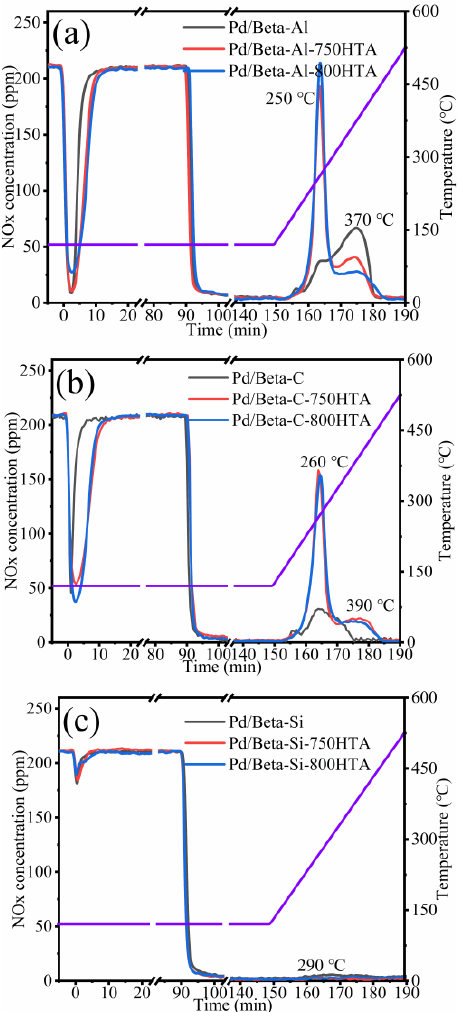
Figure 1. The NO x adsorption and storage capacity of ( a ) Pd/Beta-Al, Pd/Beta-Al-750HTA and Pd/Beta-Al-800HTA; ( b ) Pd/Beta-C, Pd/Beta-C-750HTA and Pd/Beta-C-800HTA; ( c ) Pd/Beta-Si, Pd/Beta-Si-750HTA and Pd/Beta-Si-800HTA. Feed: 200 ppm NO; 200 ppm CO, 5%H 2 O, 10%O 2 and N 2 balance. Table 1. The calculation of NO x adsorption/desorption capacity of Pd/Beta with different